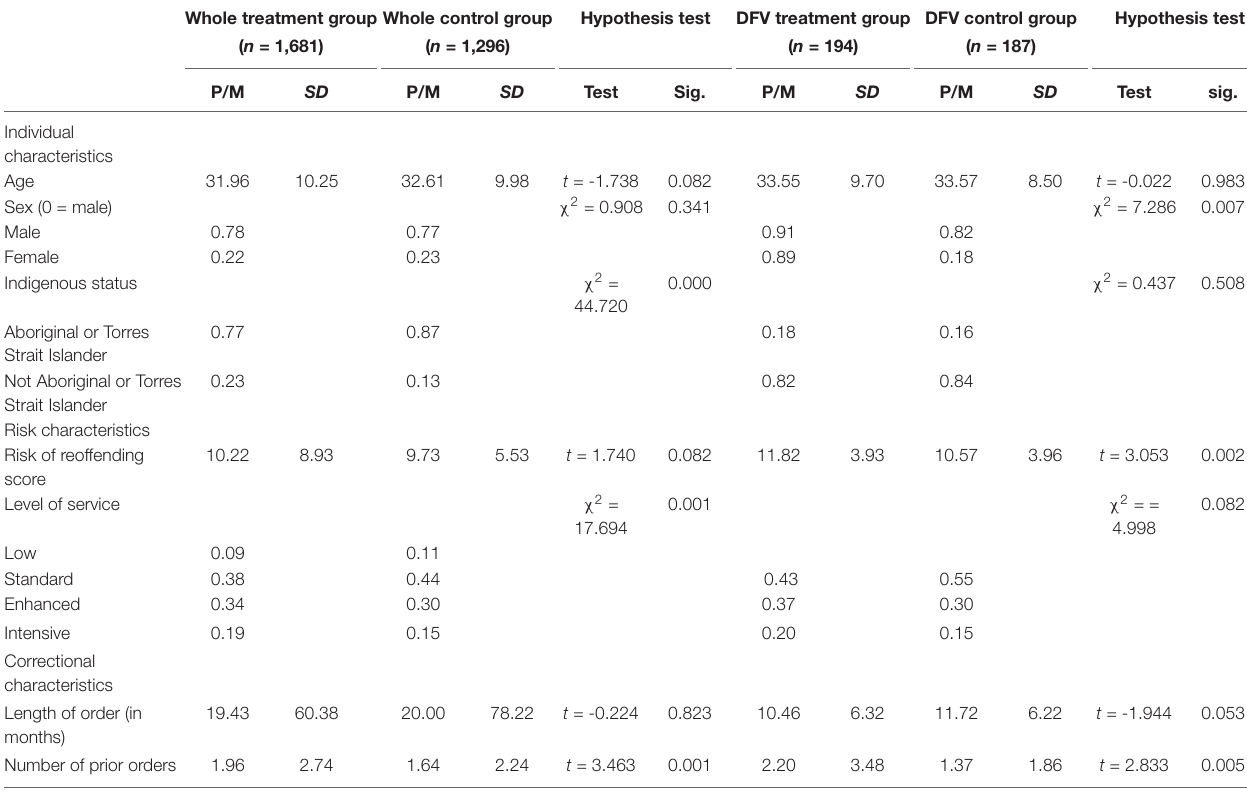
TABLE 1 | Comparison of Treatment and Control Groups.